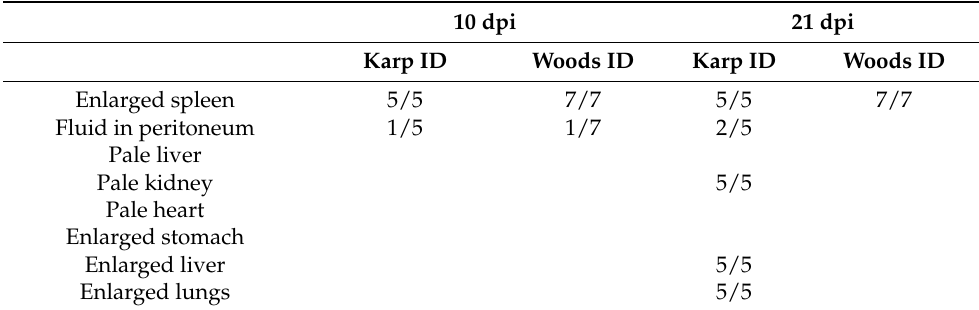
Table 1. Visual observations of affected organs observed in O. tsutsugamushi ID Karp- or Woods- challenged mice (compared to control animals) at the time of necropsy (10 and 21 dpi). The number of mice with affected organs (numerator) out of the total mice in the group (denominator) is indicated for each specific observation.